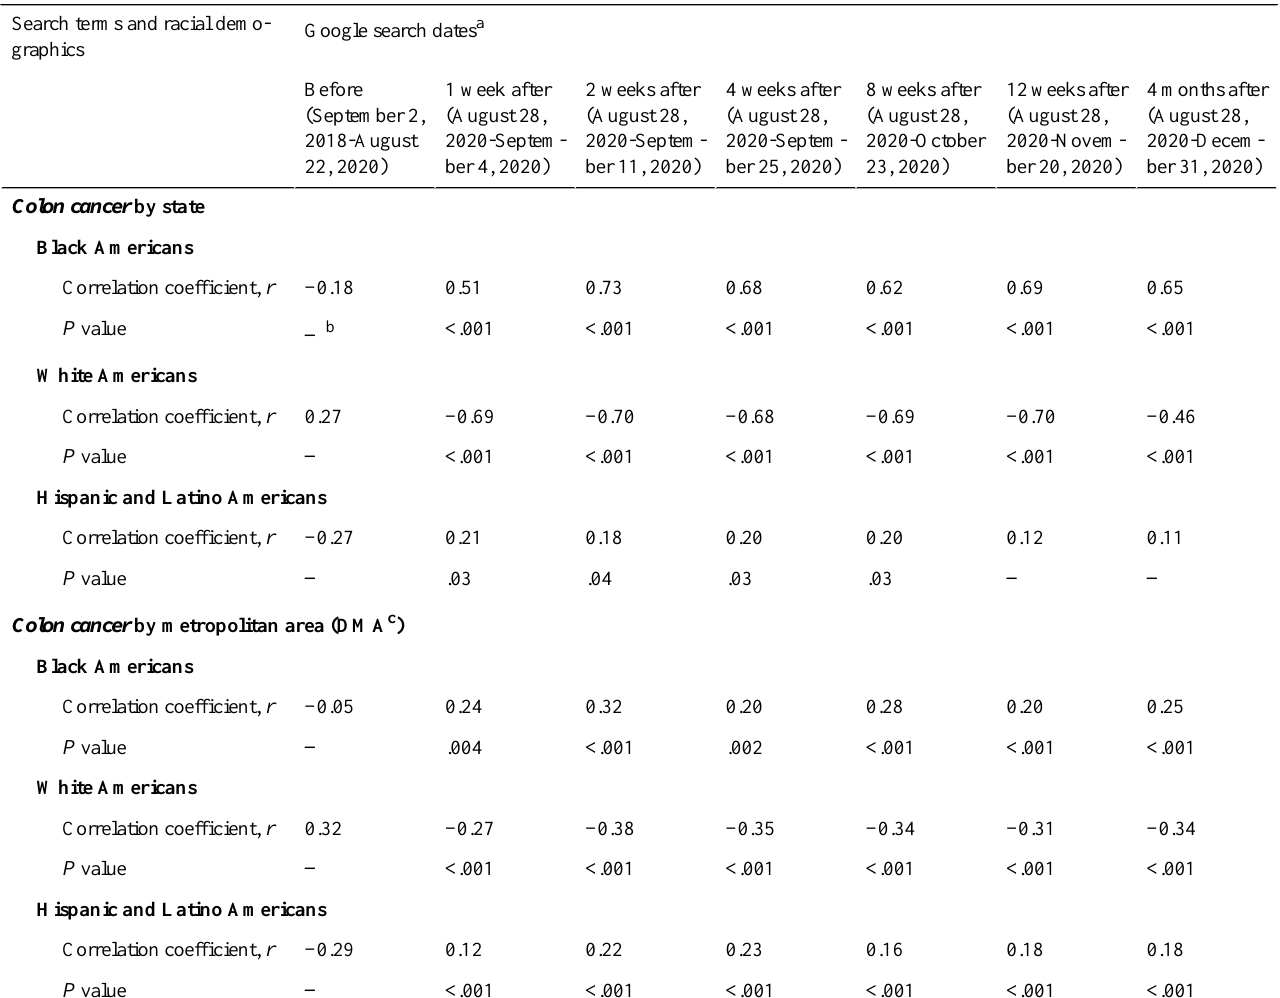
Table 1. Correlations between search interest in colon cancer and racial demographics.